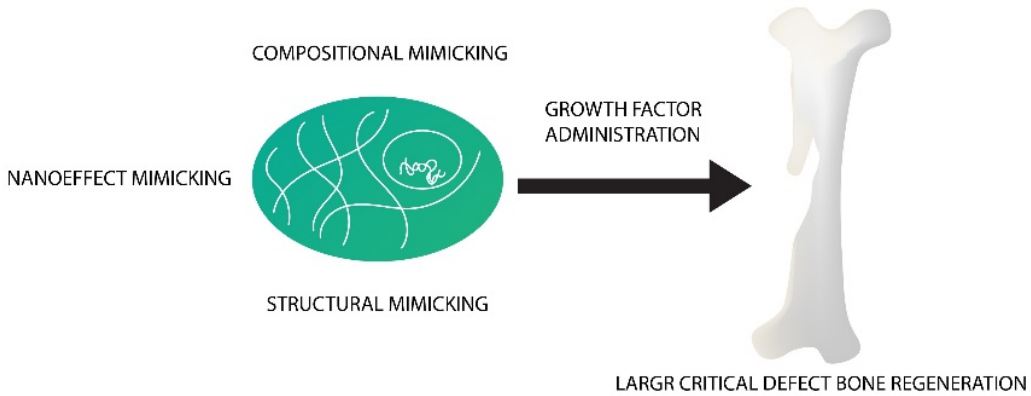
Figure 4. Schematic representation of how a synergistic combination of compositional, nanoelements, well-defined structure, and growth factor administration may endow nanomaterials with a “self-regenerative” capacity for the regeneration of large critical defect bone in a natural bone-healing way, especially at an in vivo level.